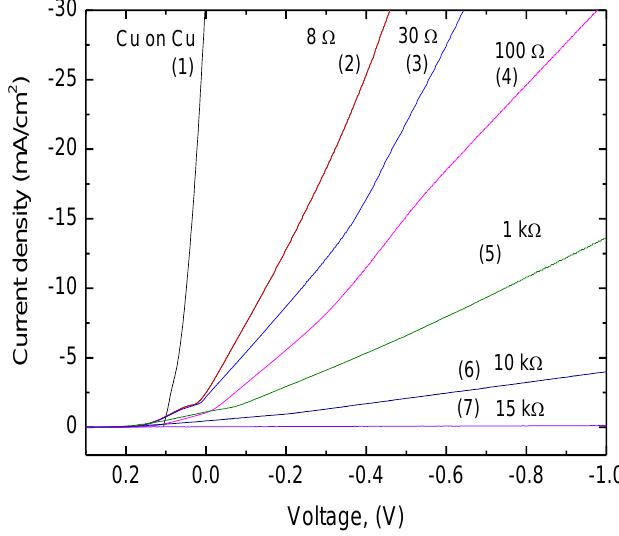
Figure 12. The voltammograms of Cu deposition on laser-treated surfaces with different sheet resistances. The voltammogram of Cu on Cu was also performed as a reference. The potential sweep rate was 2 mV/s and the potentials were given versus Ag/AgCl/KCl(sat) electrode. The measurements were carried out at room temperature using the potentiostat/galvanostat Reference 600 (Gamry Instruments, Warminster, PA,